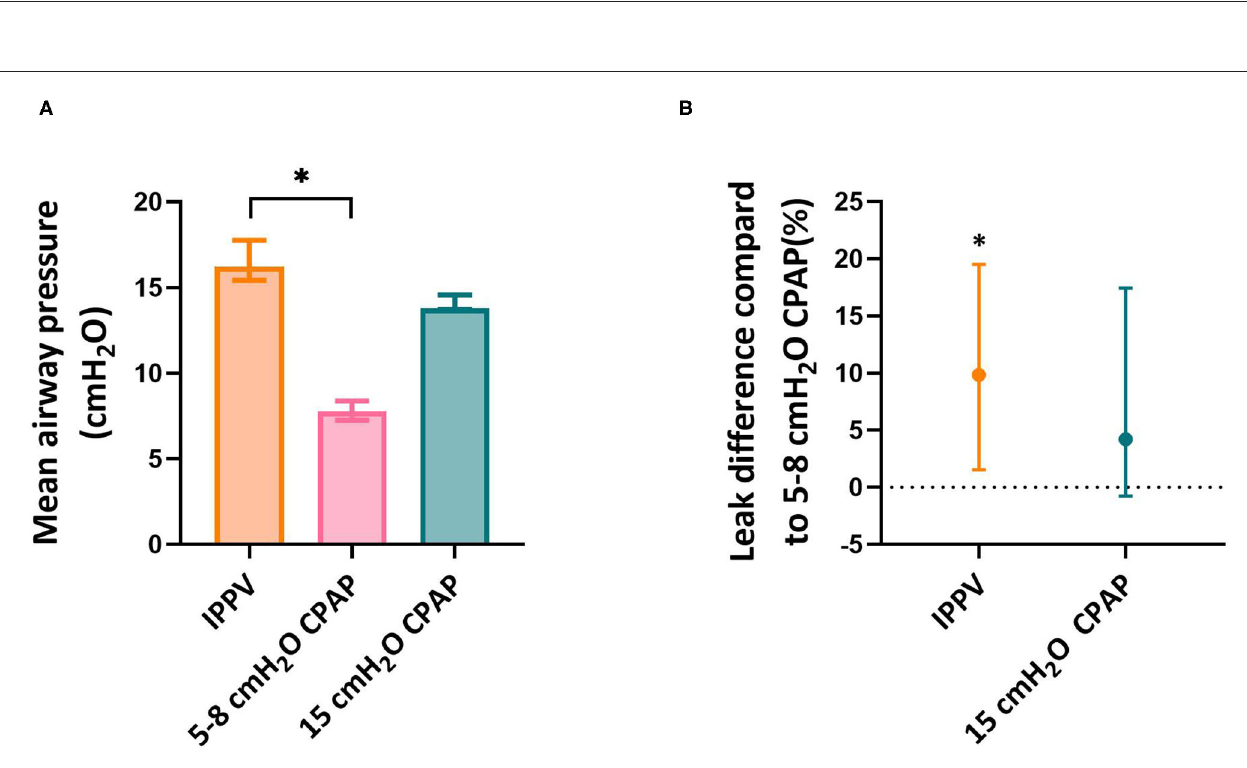
FIGURE 5 | Mean airway pressure and leak. Mean airway pressure (A) and leak (B) per respiratory support mode. Leak per respiratory support mode is calculated as difference in leak compared to 5–8 cmH 2 O CPAP as it is calculated within infants. Asterisk indicates significant